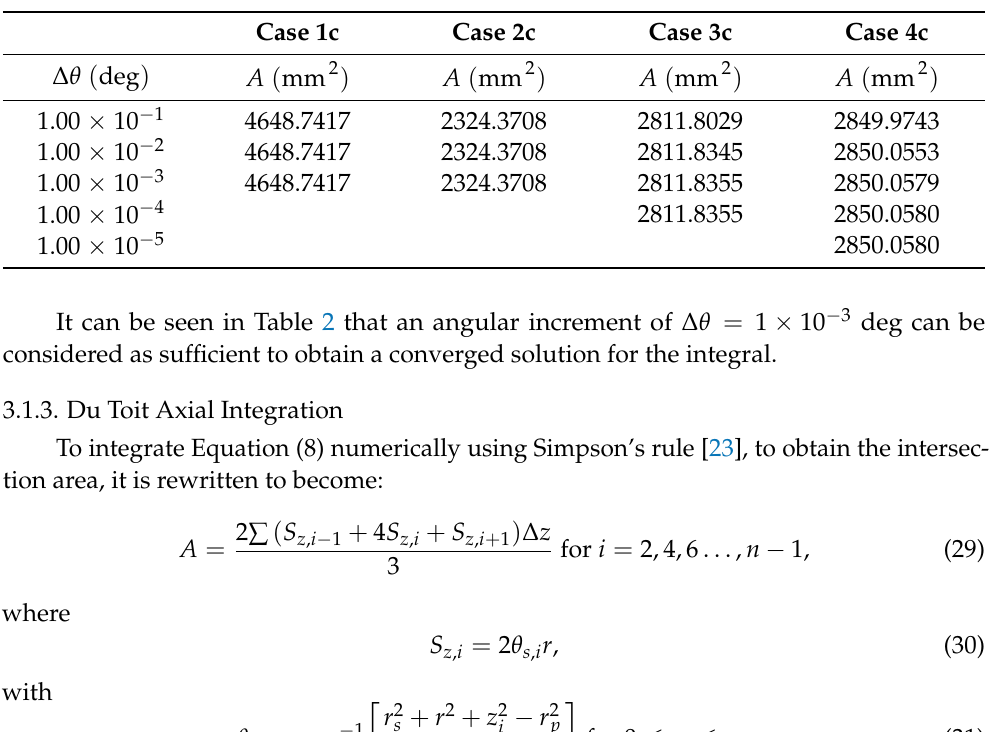
Table 2. Convergence analysis for Equation (4) [17,19].